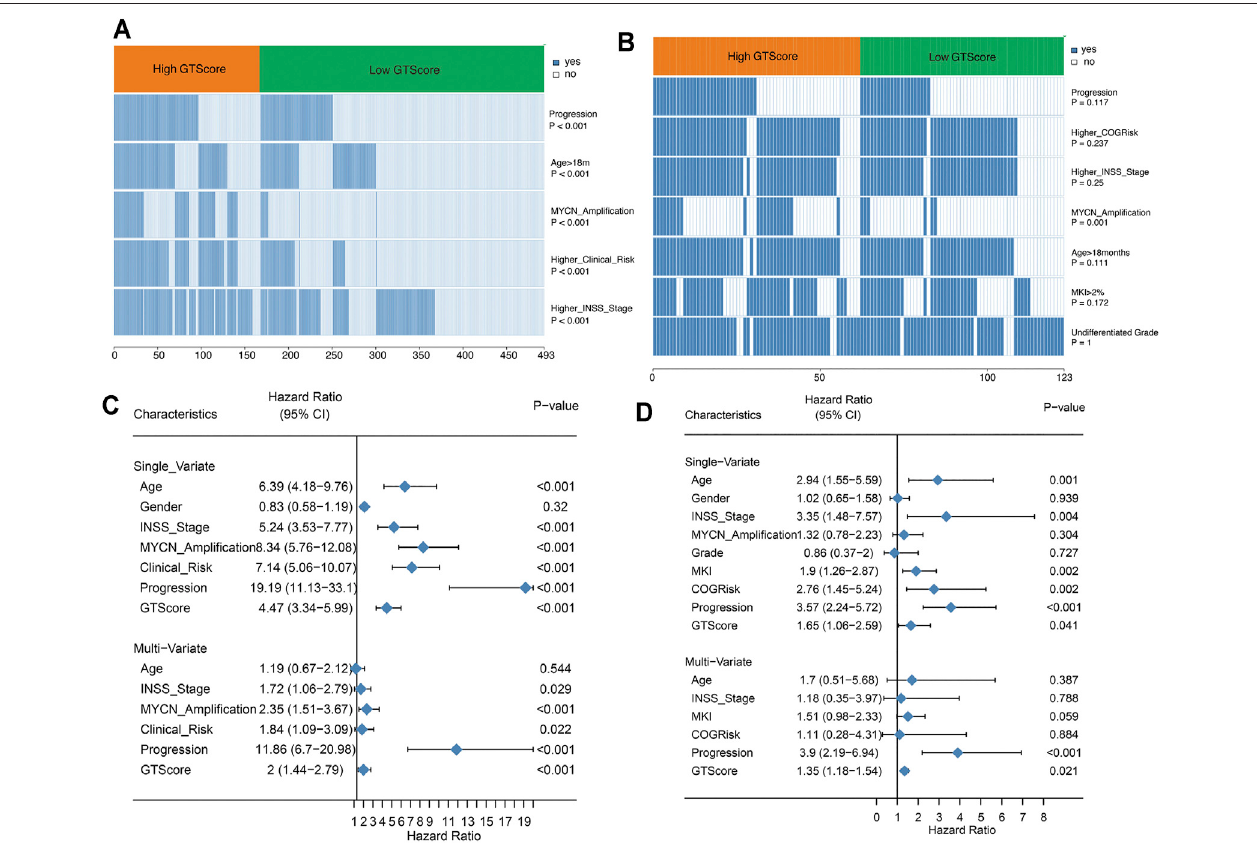
FIGURE 6 | GTscore is related to the clinical characteristics of NB and is an independent prognostic factor. The correlation heat map showing the association of GTscorewithclinicalcharacteristicsinthetrainingset (A) andvalidationset (B) .UnivariateanalysisandmultivariateanalysisoftheGTscore,age,sex,INSSstage,MYCN ampli fi cation, clinical risk, disease progression, MKI, and OS in the training set (C) and validation set (D) .